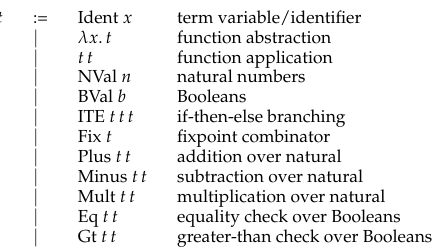
Figure 1. Extended Lambda